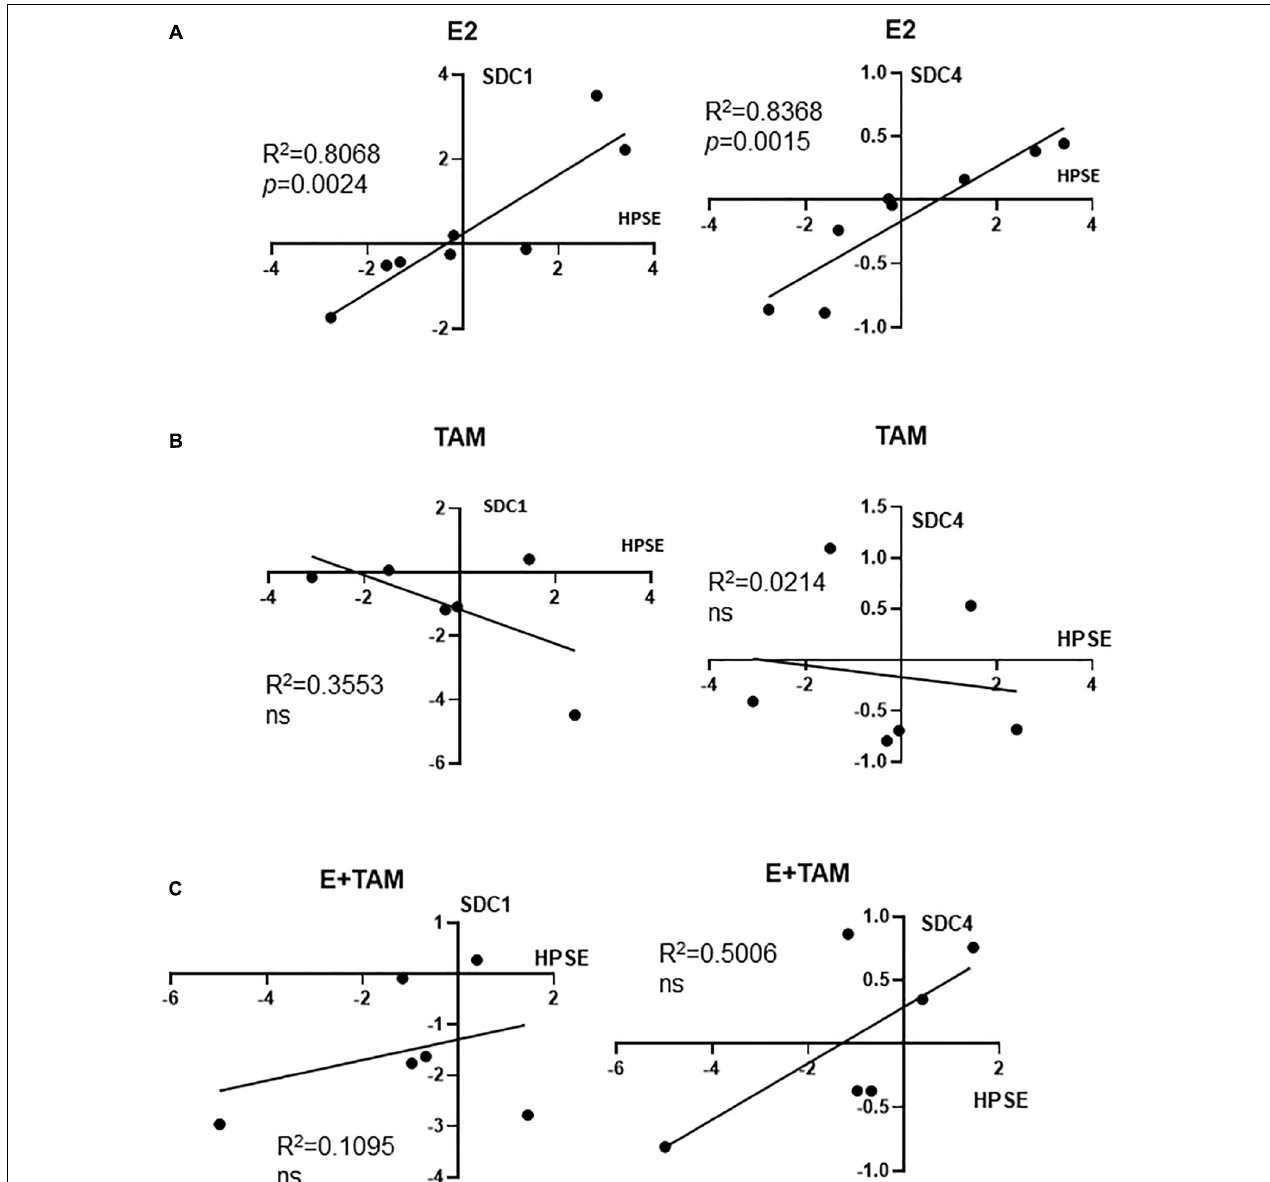
FIGURE 3 | RT-qPCR data from hormone treated explants: Correlation of HPSE with SDC1 or SDC4 in E2 (A) , Tamoxifen (B) , and E2 + Tamoxifen (C) treated explants. Expression data shown is normalized to control-treated explant mRNA control (ddCT). Each data point represents the average expression from 3